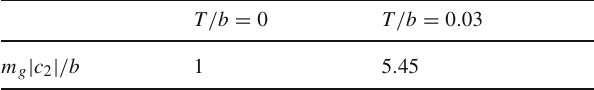
Fig. 3 The anomalous Hall conductivity as a function of M / b for dif- ferent graviton mass m g | c 2 | / b at T / b = 0 . 03. The black dashed line is for the massless case, while the colored solid line are for graviton mass m g | c 2 | / b = 0 . 5 (red), 1 . 5 (green), 3 (blue), 4 . 5 (orange), 7 (purple) from right to left respectively